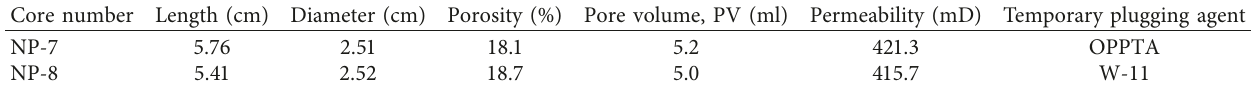
Table 2: The parameters of natural cores with the artificial fracture.